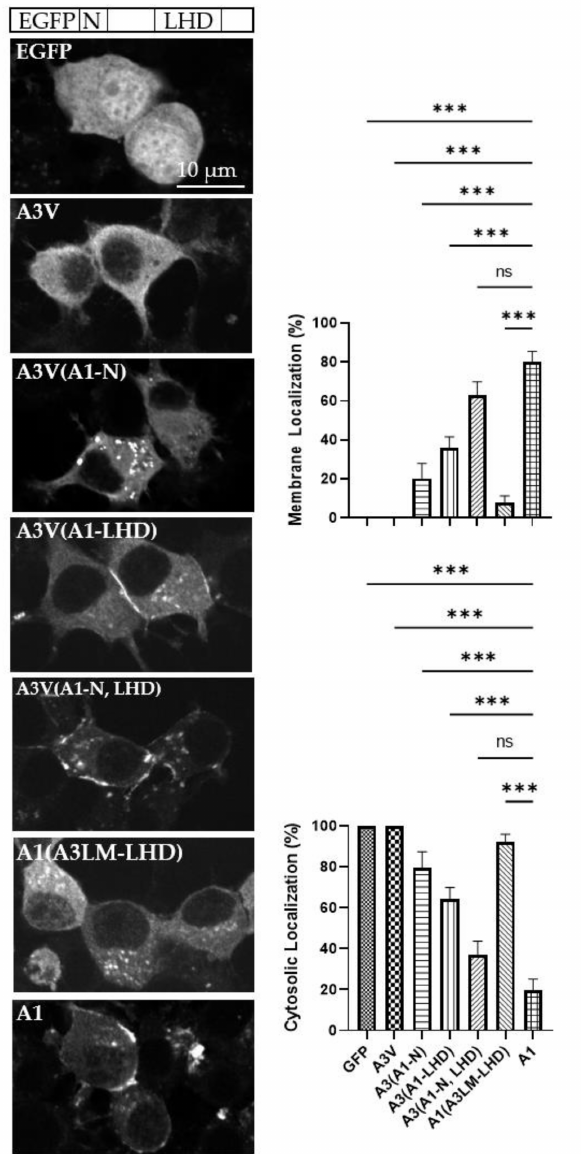
Figure 4. LC/A1 N and LHD are necessary and sufficient to localize A3V to the plasma membrane of N2A cells. After overnight transfection, N2A cells were fixed with 4% paraformaldehyde and imaged for EGFP fluorescence (excitation 488 nm and emission 509 nm). (Left) Schematic representation of the construct with the region of interest depicted as EGFP fluorescent tag, N terminus residues 1–17 (N), and low homology domain (LHD) residues 268–357. Representative images show the steady-state localization of EGFP, GFP-LC/A3V, EGFP-LC/A3V(A1-N), EGFP-LC/A3V(A1-LHD), EGFP- LC/A3V(A1-N, LHD), EGFP-LC/A1(A3LM-LHD), or EGFP-LC/A1 (A1). (Right) Percentage of EGFP membrane- or cytosol-localized. Ten random fields were selected and counted for membrane (upper) or cytosolic (lower) localization. Mean and SEM were evaluated, with ordinary one-way ANOVA with Dunnett’s multiple comparisons test using A1 as the control column: ns, not significant; *** p <